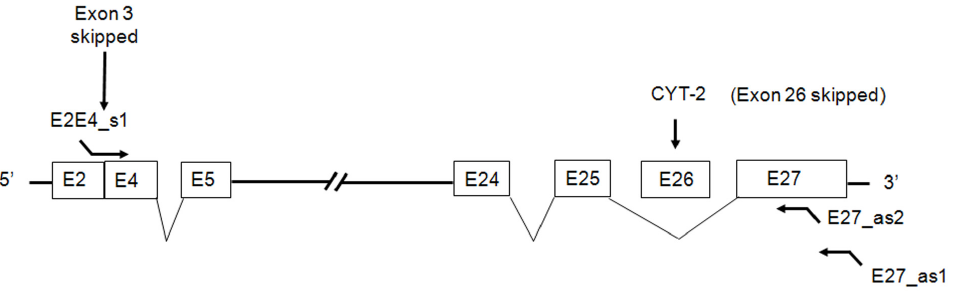
Figure 1. Organization of the ErbB4 del.3/CYT-2 transcript cloned from the human fetal brain. Horizontal lines with ‘‘//’’ sign represent exons from E6 to E23. Exons are shown in the order in which they occur in the transcript. The skipped exons are indicated. The length of each exon is not drawn to scale The PCR primers are indicated as forward or reverse bent arrows, respectively. Names of the primers are shown.